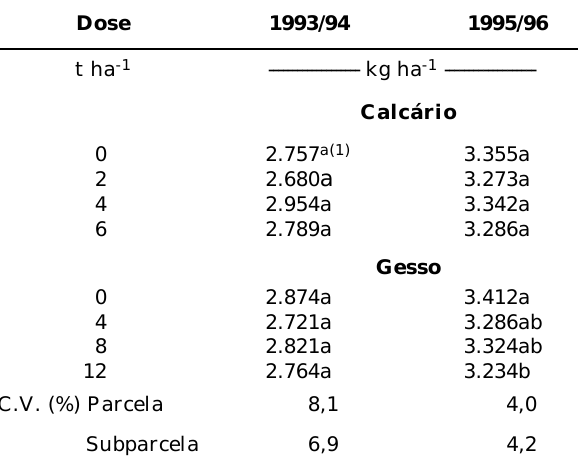
(Figura 4) e 36 mmol dm -3 de cálcio (Figura 3), até à c profundidade de 80 cm. Isto significa que cerca de 60% do S-SO e 40% do cálcio da dose máxima de gesso 4 aplicada (12 t ha -1 ) foram lixiviados para